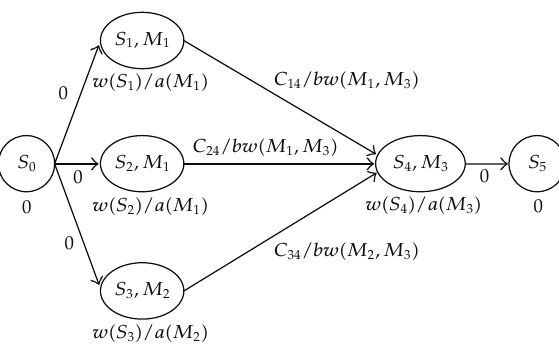
Figure 3: Task-resource assignment graph (cid:3) T-RAG (cid:4)